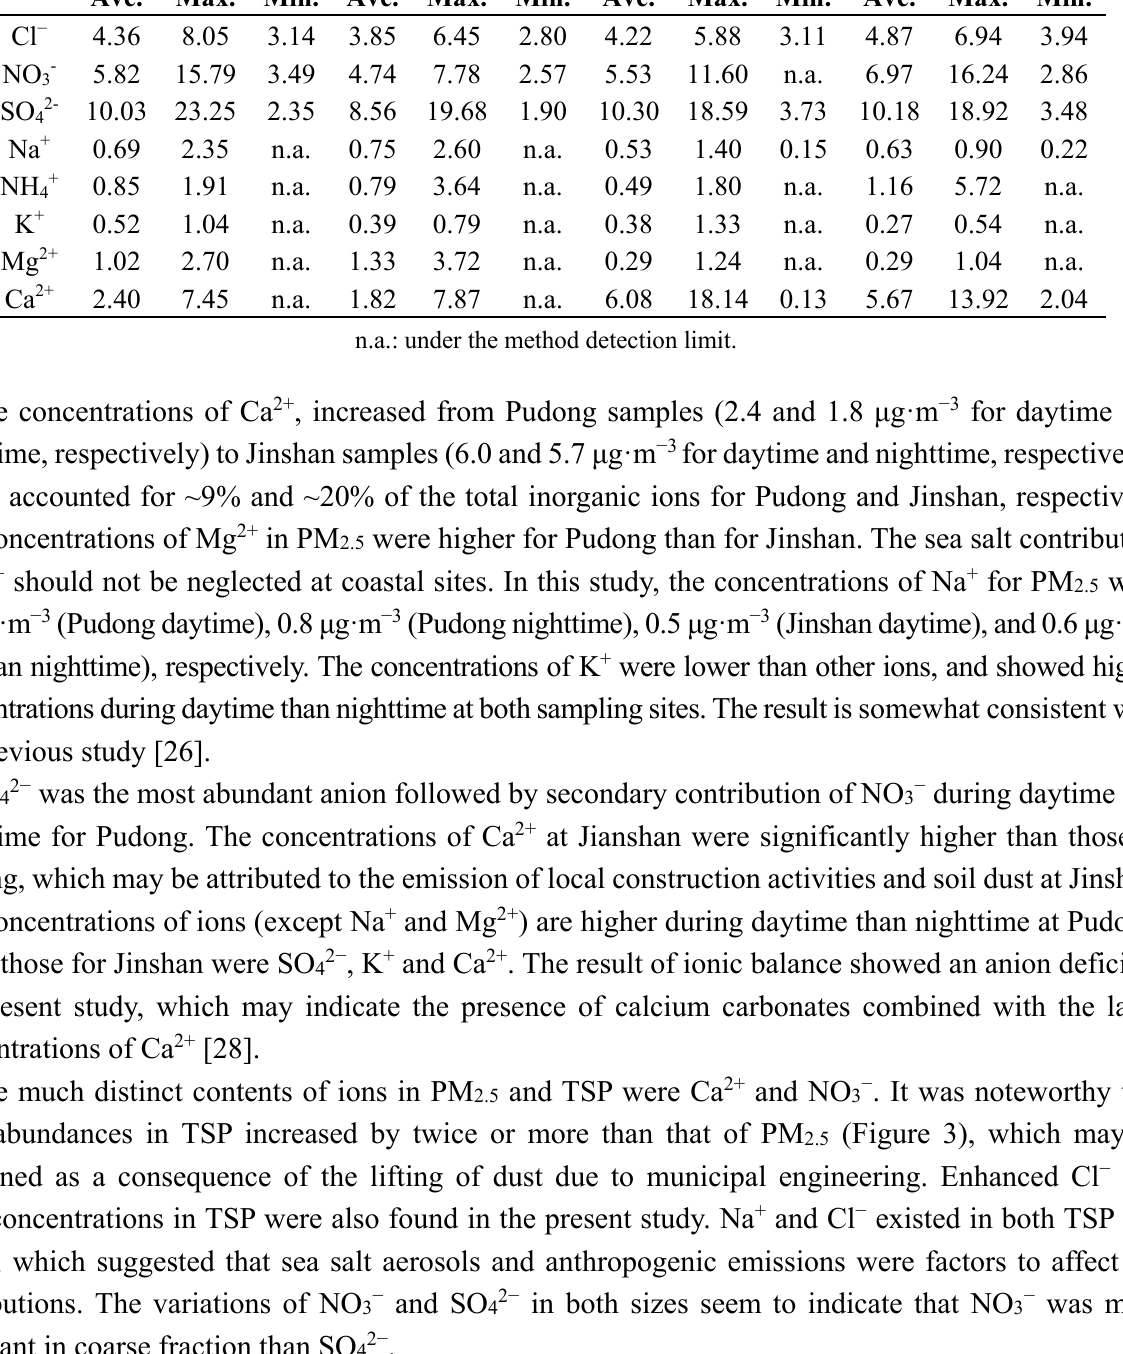
Table 2. The concentrations of water soluble ions for PM 2.5 at Pudong and Jinshan ( μ g·m − 3 ). Pudong Daytime Pudong Ions